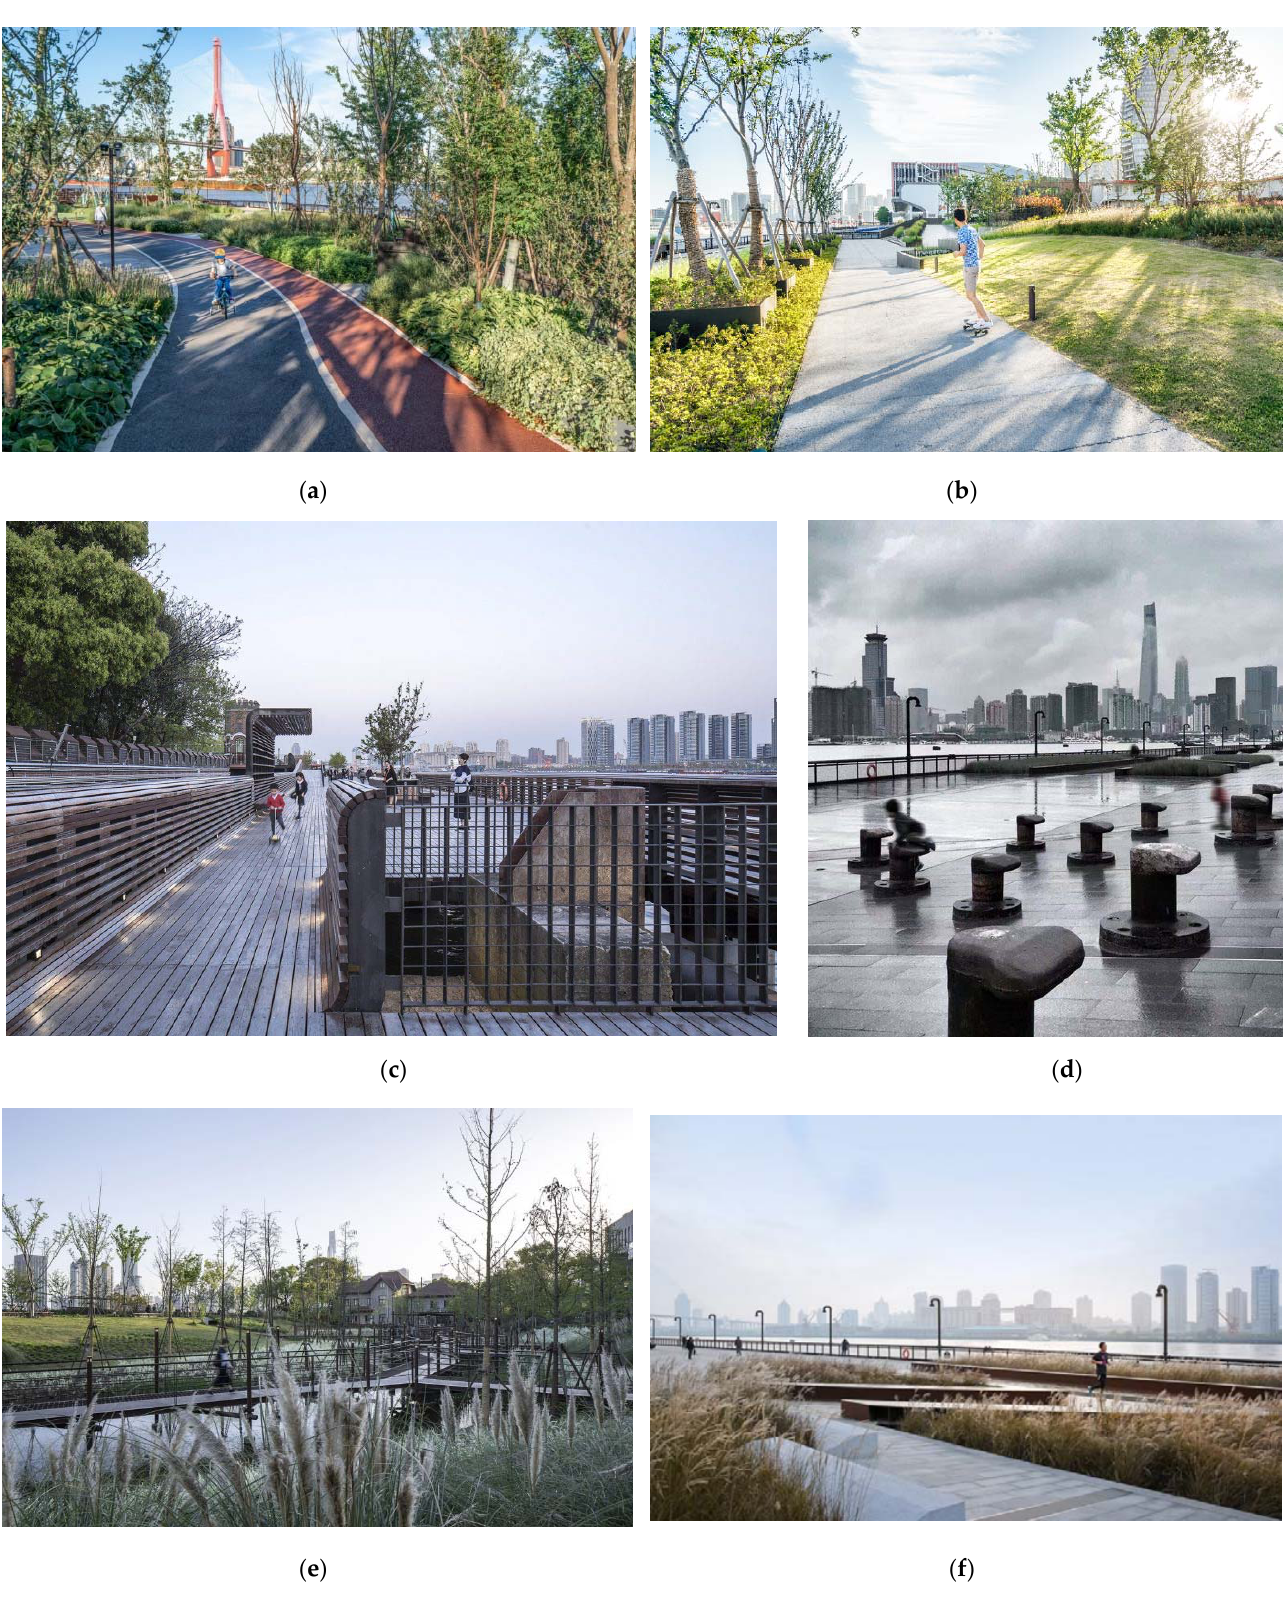
Figure 13. Jogging, cycling and walking ways alongside Huangpu River ( a , b ); an array of preserved moorings as the main landscape factor for a plaza; the preserved mooring structure in front of the water plant ( c , d ); wetland, passageway and preserved historical building ( e ); landscape with natural features ( f ) Source: ( a , b ) DA Landscape, Photographer: JIN Xiaohui; source ( c – f ): TJAD Original Design Studio, Photographer: ZHANG Yong\SU Shengliang.